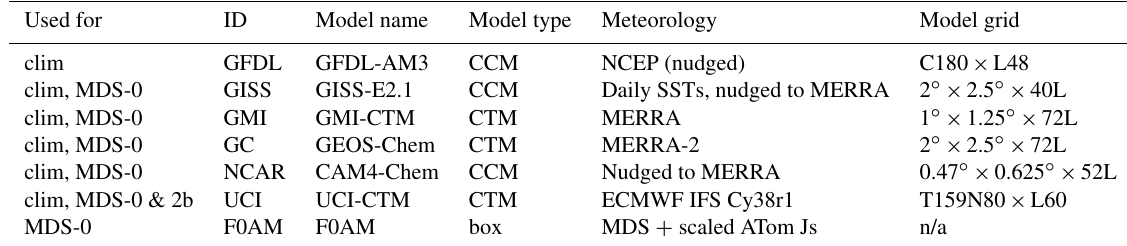
Table 1. Chemistry models.